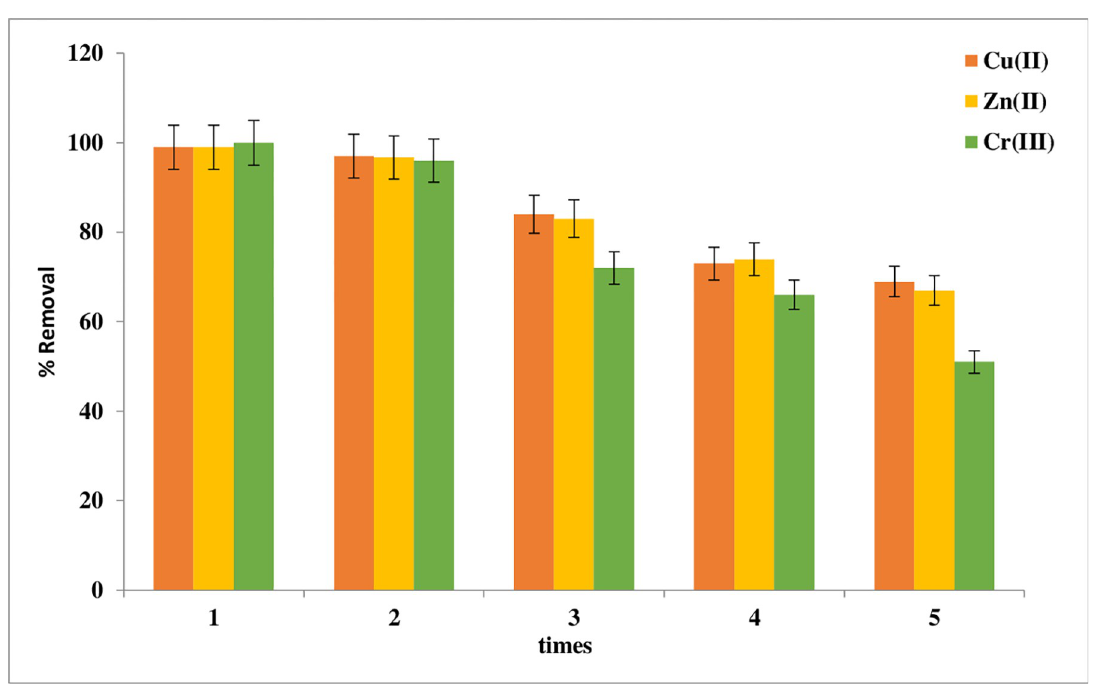
Fig 12. Reusability of imine for removal percent to Cu(II), Zn(II), and